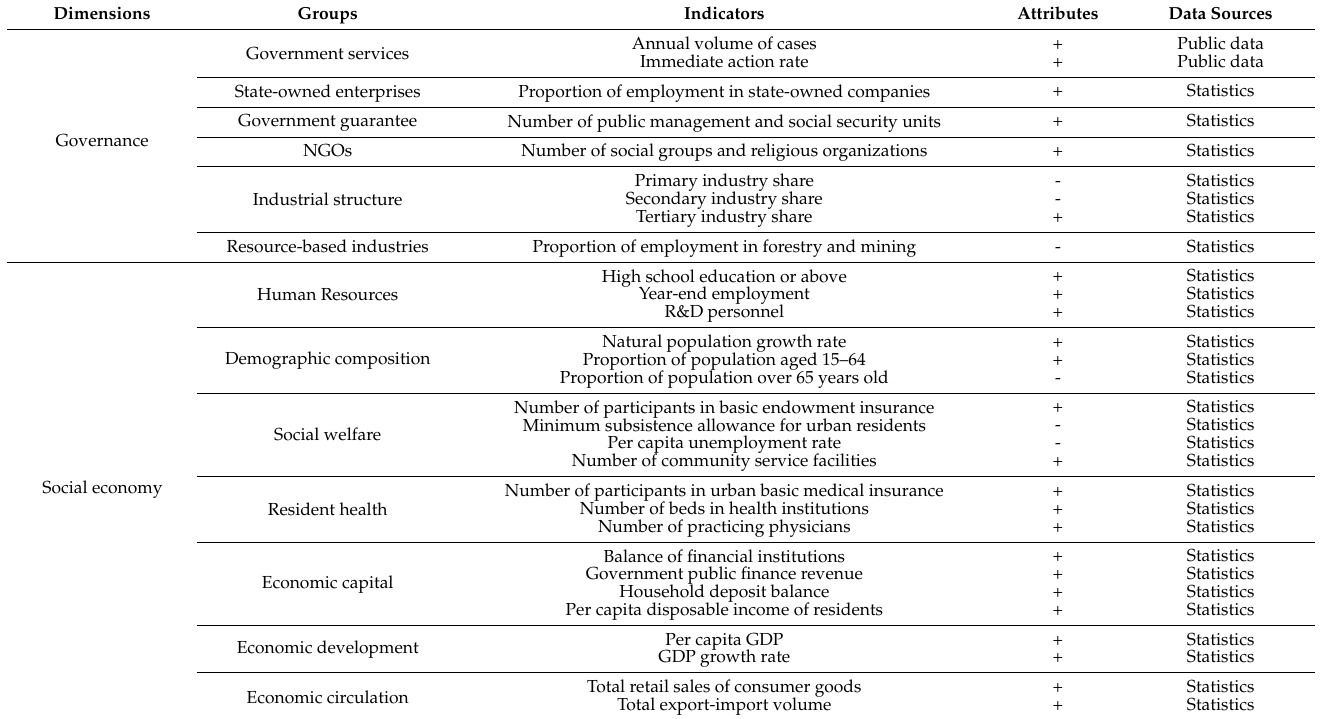
Table 2. Resilience indicator system of